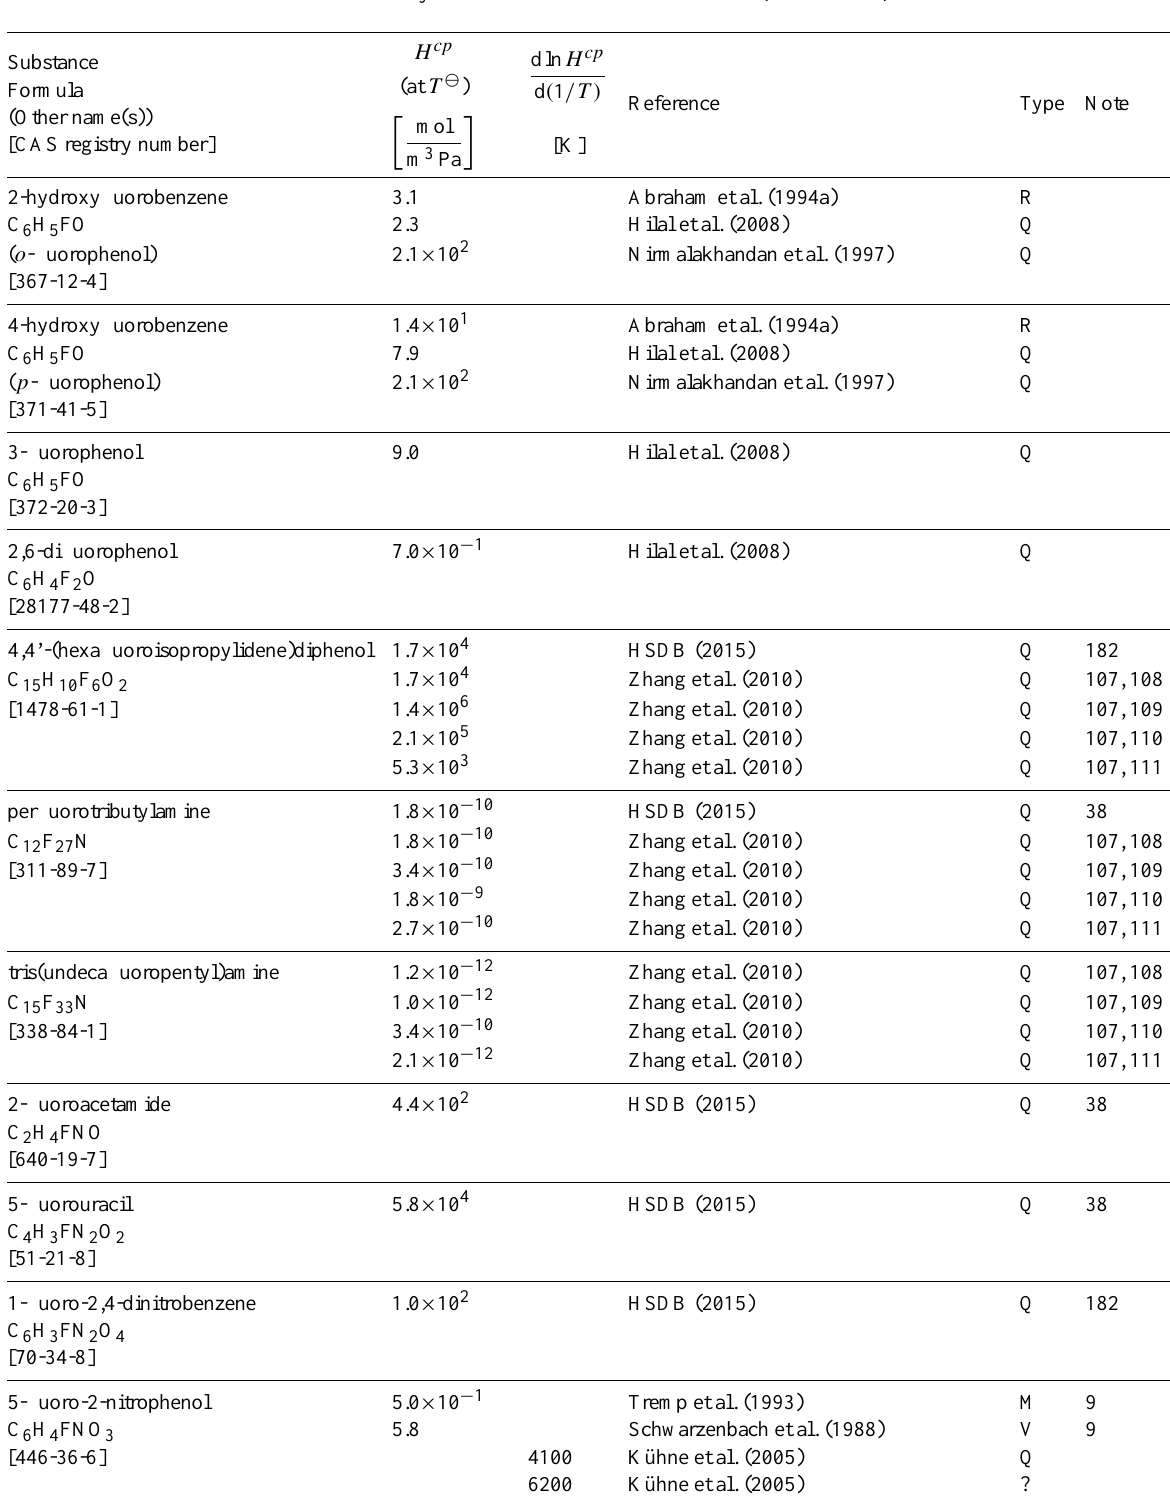
Table 6: Henry’s law constants for water as solvent